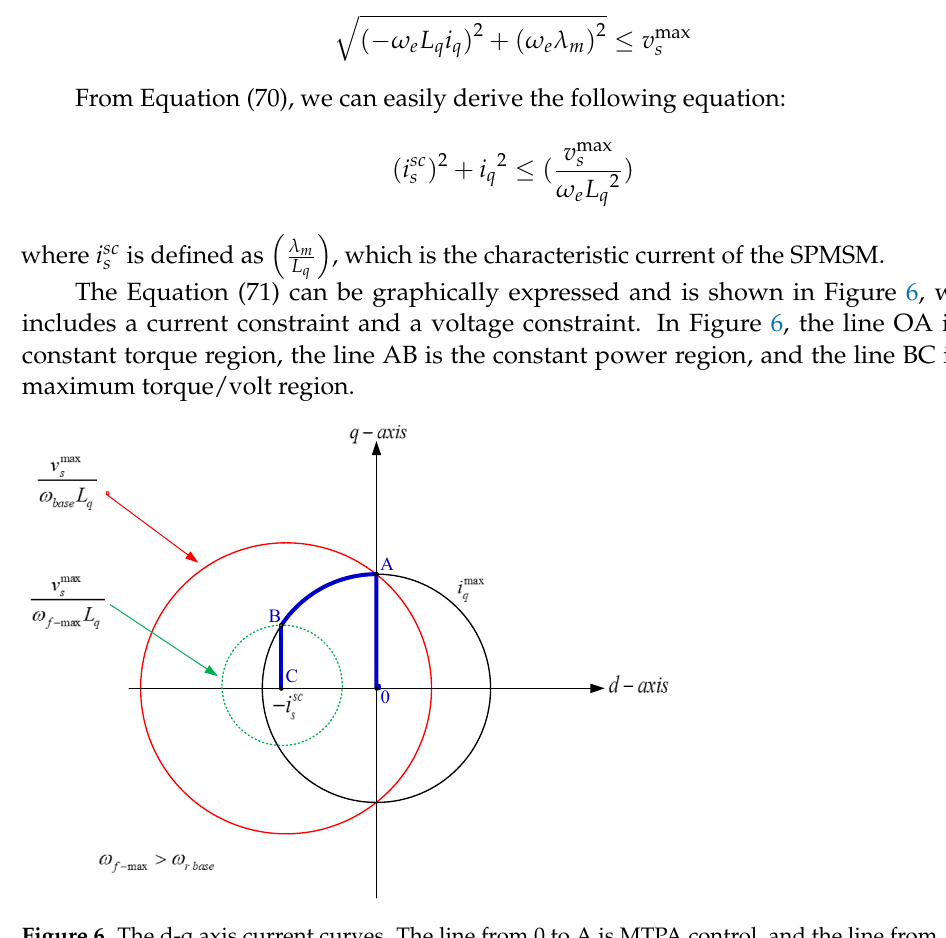
Figure 6. The d-q axis current curves. The line from 0 to A is MTPA control, and the line from A to B is Flux-weakening control. is Flux-weakening